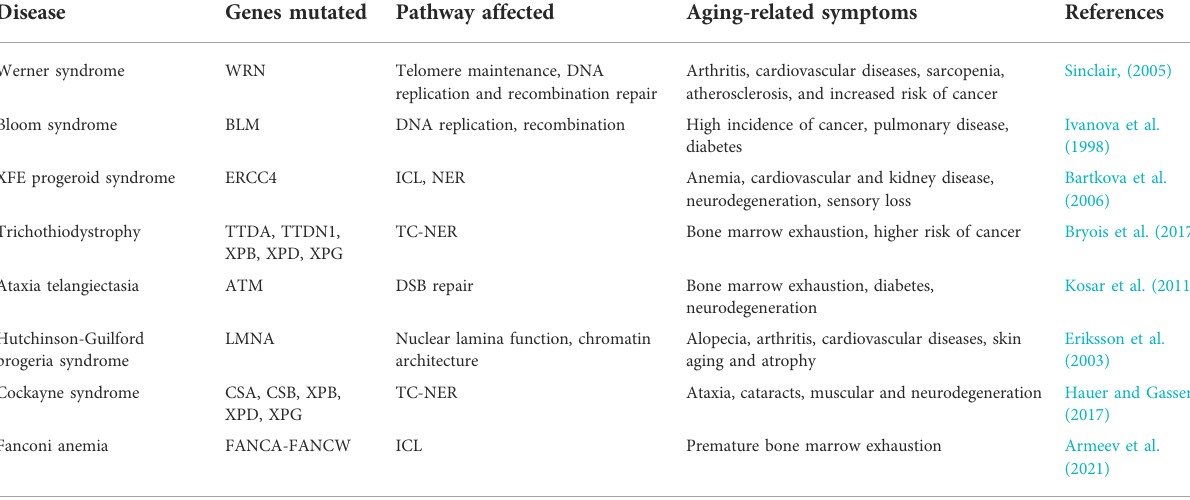
TABLE 2 Age-associated disorders which directly affect DNA repair and genome